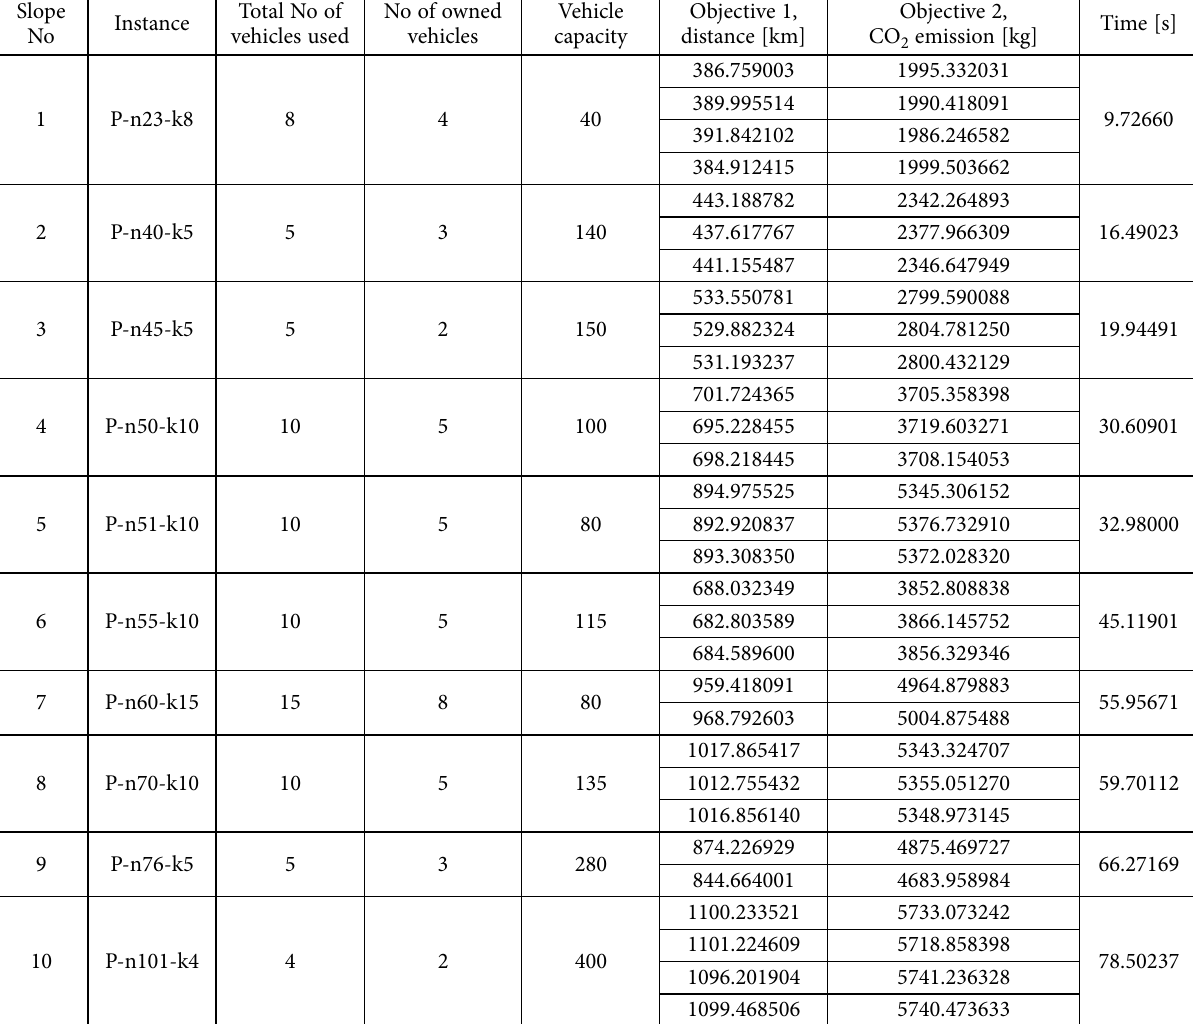
Table 3. Results of independent runs of the multi-objective mixed